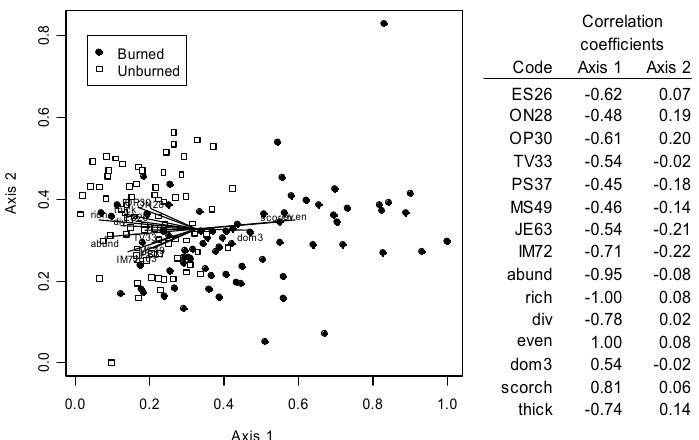
Figure 2. NMS ordination of oribatid mite assemblages from 90 east–west transects in burned and unburned split-plots. The first NMS axis summarizes most of the fire related alterations in assemblage structure. Vectors overlaid upon the joint-plot represent the major oribatid species abundance and assemblage structure gradients, and two habitat quality correlates of low intensity fire. Oribatid species codes are explained in Table 1; abund is total oribatid mite abundance; rich = oribatid species richness; div is oribatid assemblage heterogeneity, estimated with Brillouin diversity coefficients; even is the Camargo coefficient of oribatid assemblage evenness; dom3 is the proportional abundance of the three most abundant oribatid taxa; scorch is the proportion of eight samples on each transect that exhibited physical evidence of scorching; and thick is the mean litter thickness from which oribatid samples were obtained.